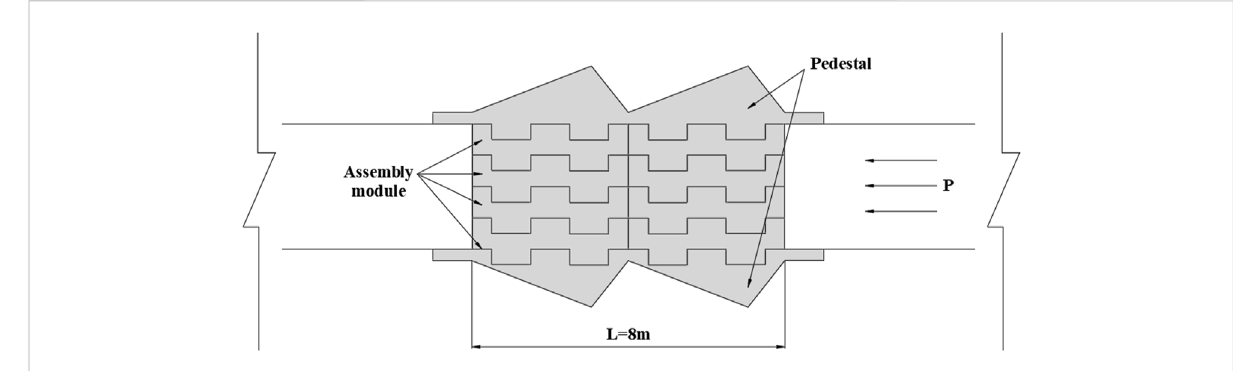
FIGURE 7 Design drawing of 3D printed mine waterproof